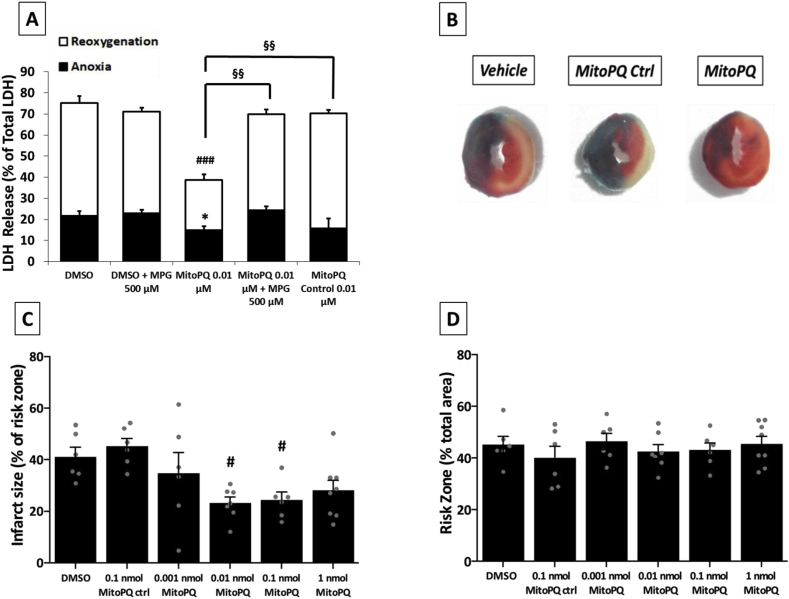
Effects of MitoPQ on cardiomyocytes viability both in vitro and in vivo. A) Cell death measured by LDH release from isolated NRVMs treated for 2 h with 0.01 μM MitoPQ or 0.01 μM MitoPQ control compound, with or without 500 μM MPG. *p < 0.05 vs DMSO Anoxia, ###p < 0.001 vs DMSO Reoxygenation, §§p < 0.01 vs MitoPQ. B) Representative infarct slices from hearts treated with vehicle, MitoPQ control compound 0.01 nmol MitoPQ. C) Infarct size in hearts of mice exposed to acute myocardial I/R, in presence or absence of 0.01 nmol MitoPQ control compound or the indicated dose of MitoPQ. *p < 0.05 vs DMSO. D) Risk zone in heart of mice exposed to acute myocardial I/R, in presence or absence of 0.01 nM MitoPQ control compound or the indicated dose of MitoPQ. A: at least 4 wells (cell density: 1.5 × 105 cells/well in 24 wells plates) were analysed per condition in each experiment and all the experiments were performed at least three times. Data are expressed as mean ± SEM. B-D: n = 6-8. Data are expressed as mean ± SEM. #p < 0.05. Overall Anova p = 0.0053.